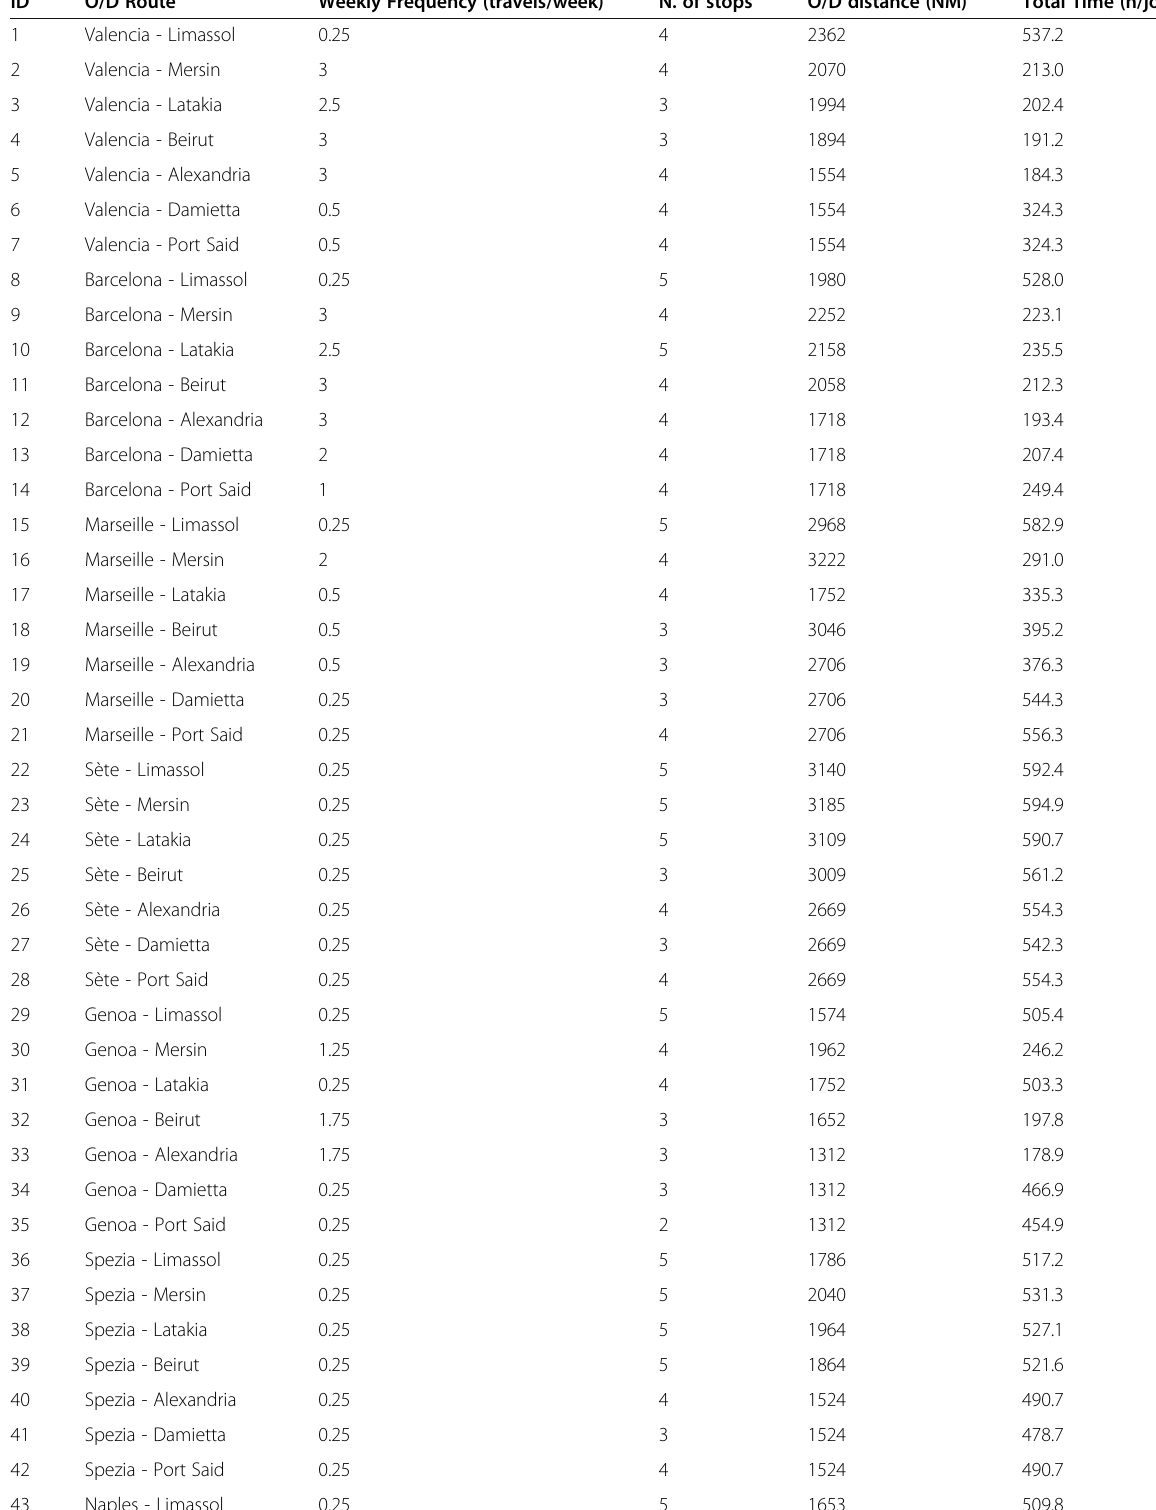
Table 19 General features of the existing